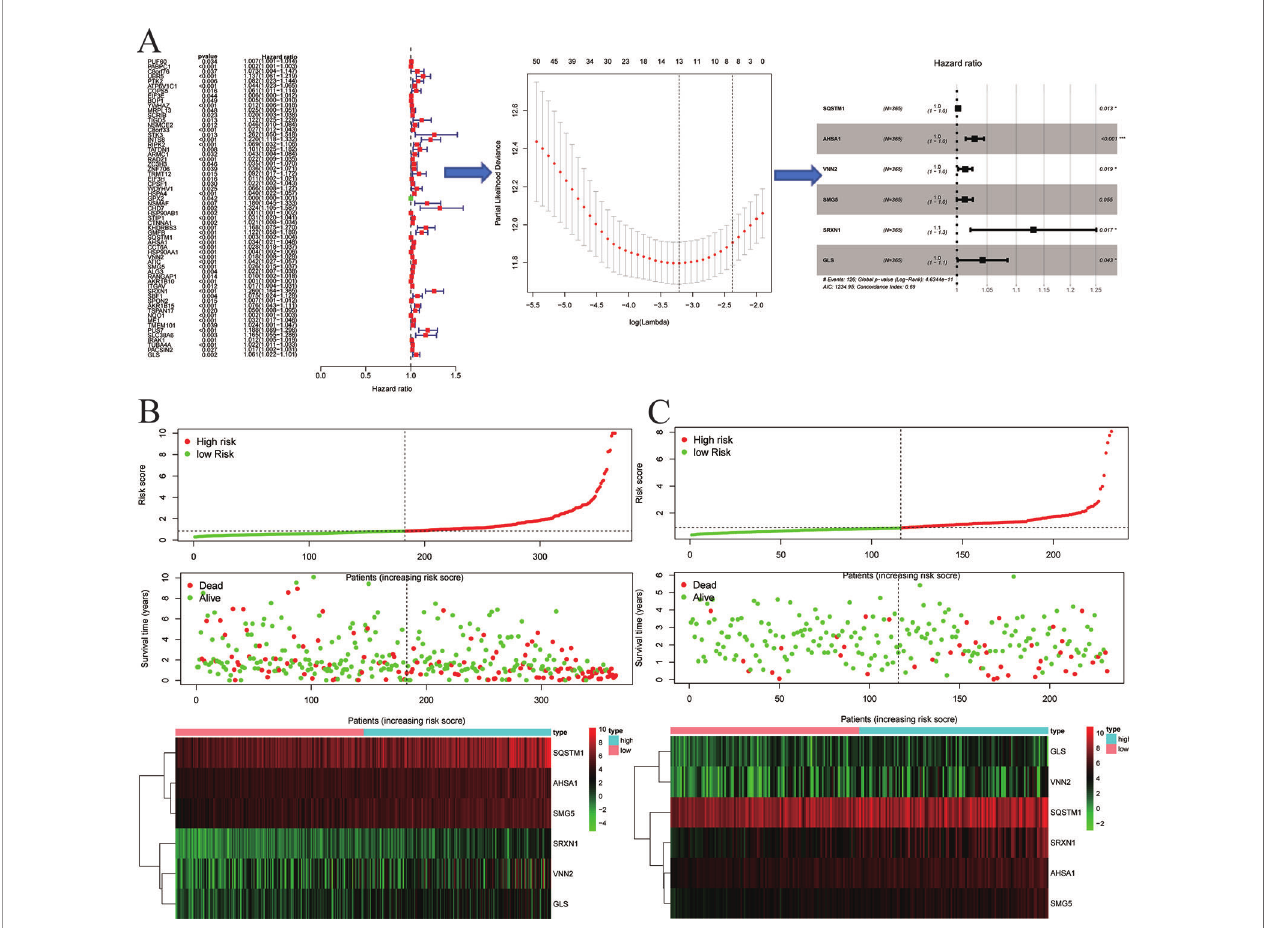
FIGURE 3 | Signature-based risk score is a promising marker in the training and validation cohorts. (A) The process of building the signature containing six genes most correlated with overall survival (OS) in the training set. The hazard ratios (HRs), 95% con fi dence intervals (CIs) calculated by univariate Cox regression, and the coef fi cients calculated by multivariate Cox regression using LASSO are shown. (B , C) Risk score distribution, survival overview, and heatmap for patients in the TCGA (B) and ICGC (C) datasets assigned to high- and low-risk groups based on the risk score.